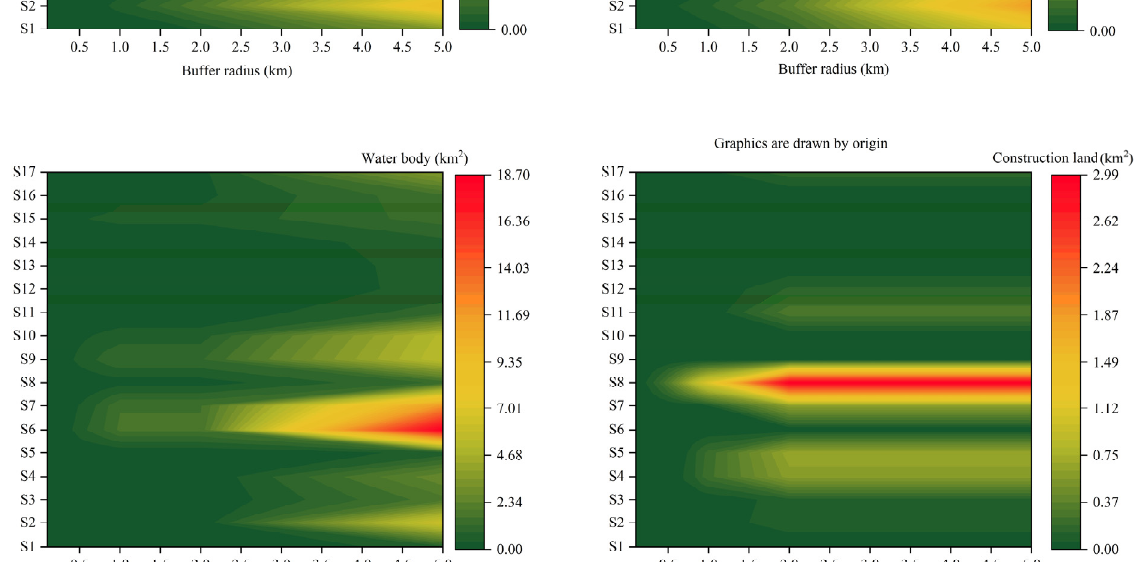
Figure 7. Land use structure at 17 locations within the Maotiao River Basin (Gizhou province, SW China) in 2020.